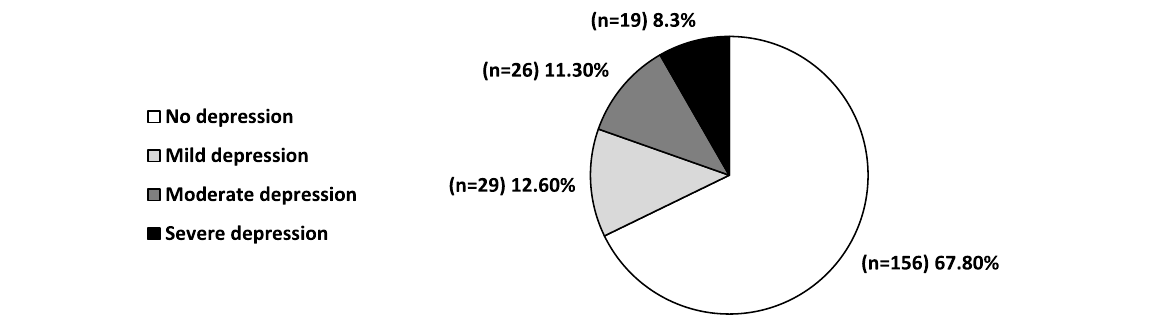
Fig. 2 Severity of depression (BDI) (depression = 32.2%, no depression